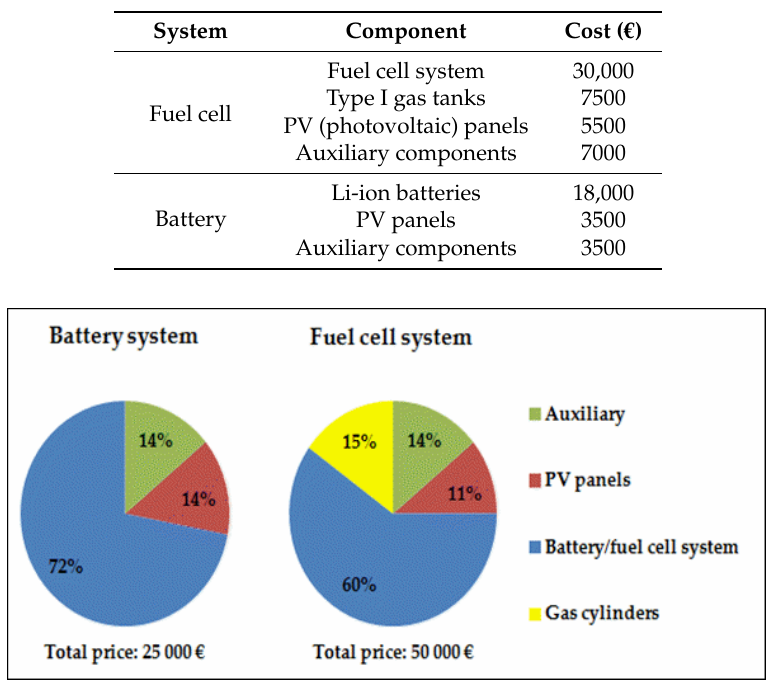
Table 1. Costs of the main components for the stationary systems.